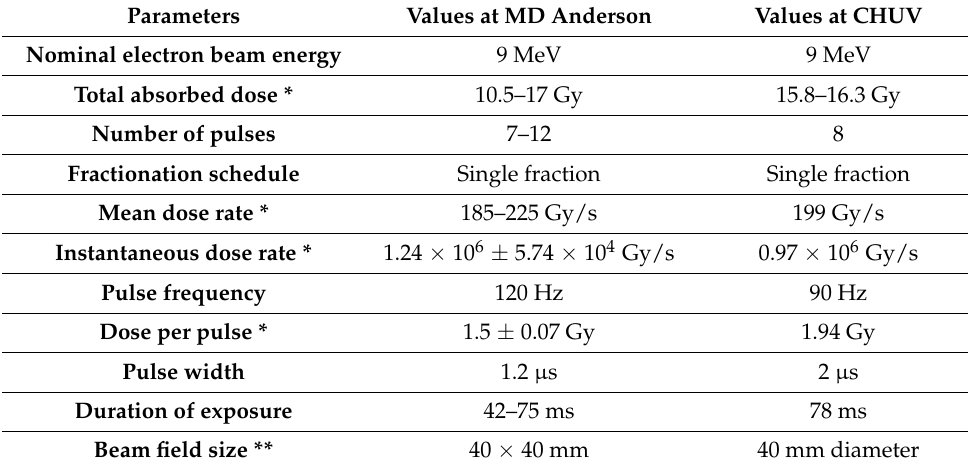
Table 1. Radiation beam parameters used at both institutions. Parameters Values at MD Anderson Values at CHUV Nominal electron beam energy 9 MeV 9 MeV Total absorbed dose * 10.5–17 Gy 15.8–16.3 Gy Number of pulses 7–12 8 Fractionation schedule Single fraction Single fraction Mean dose rate * 185–225 Gy/s 199 Gy/s Instantaneous dose rate * 1.24 × 10 6 ± 5.74 × 10 4 Gy/s 0.97 × 10 6 Gy/s Pulse frequency 120 Hz 90 Hz Dose per pulse * 1.5 ± 0.07 Gy 1.94 Gy Pulse width 1.2 µ s 2 µ s Duration of exposure 42–75 ms 78 ms Beam field size ** 40 × 40 mm 40 mm